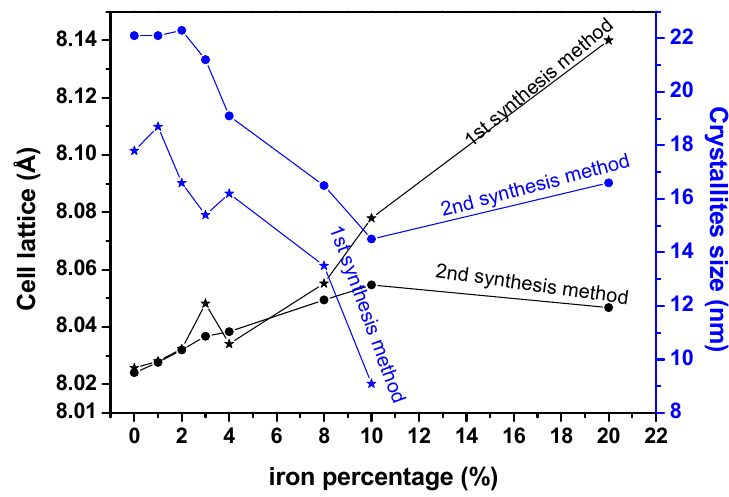
Figure 6. Variation of parameter lattice and crystallites size with iron percentage.